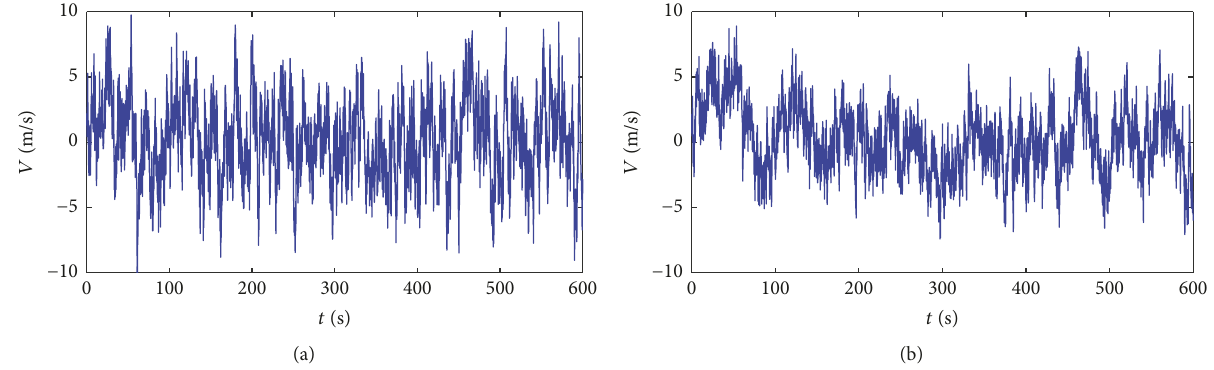
Figure 4: The fluctuating wind speed time history under wind fields 1 and 2.